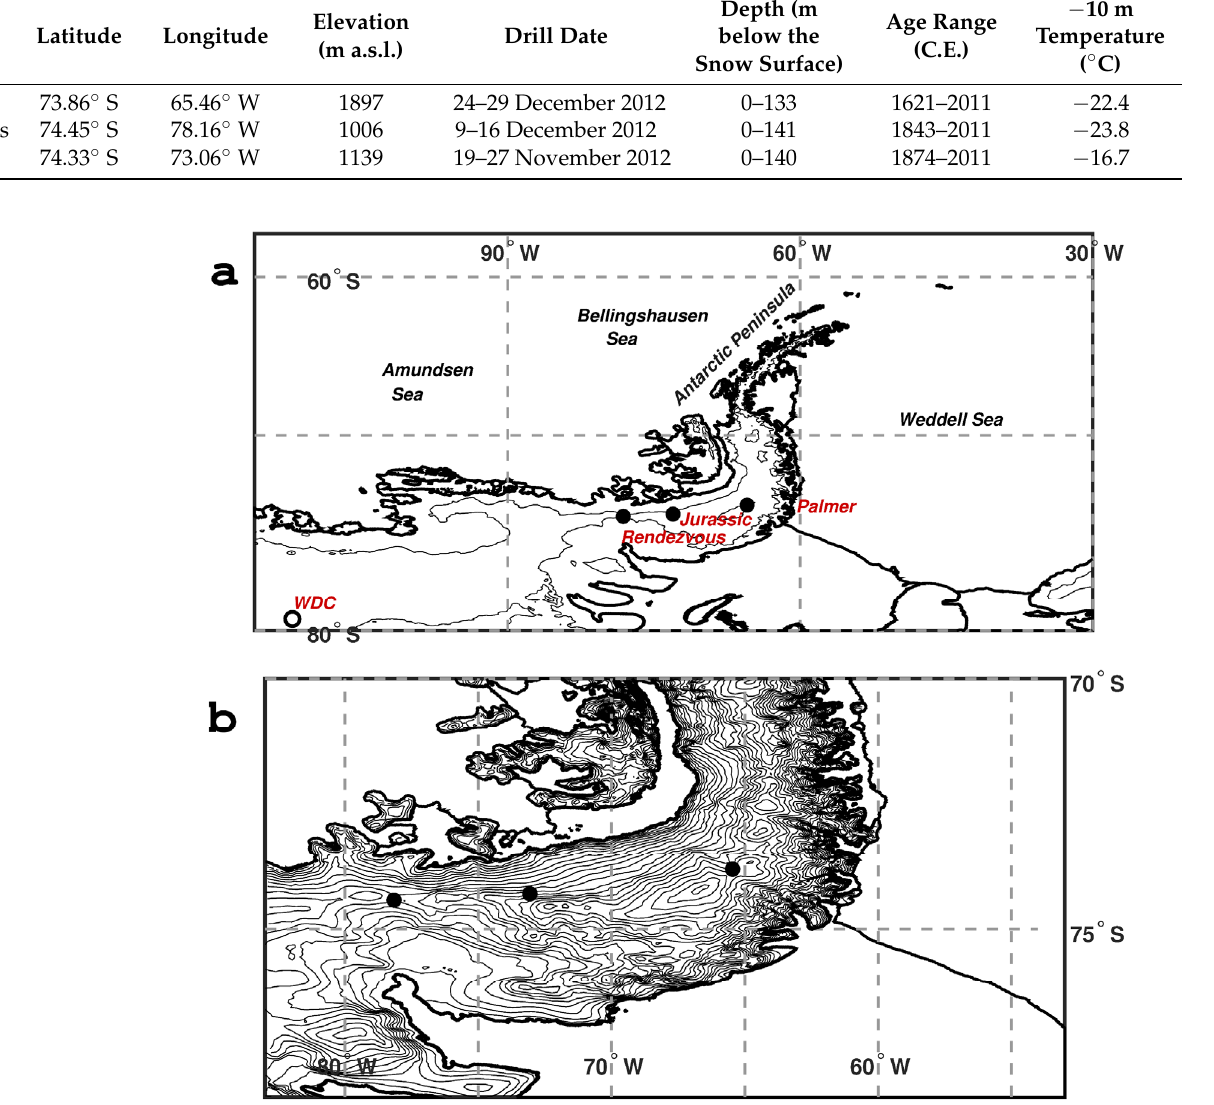
Figure 1. Antarctic location maps. Ice-core sites for which chronologies are established in this study are indicated by black dots. ( a ) The location of a WDC core (WDC06A) is indicated by a black circle. Contours (thin black lines) with 1000 m spacing indicate elevation above sea level [20,21]. ( b ) shows a blow-up map of the Antarctic Peninsula ice core locations. Contours (thin black lines) with 100 m spacing indicate elevation above sea level [20,21]. WDC—WAIS Divide ice core. Table 1. Drill site and core characteristics.